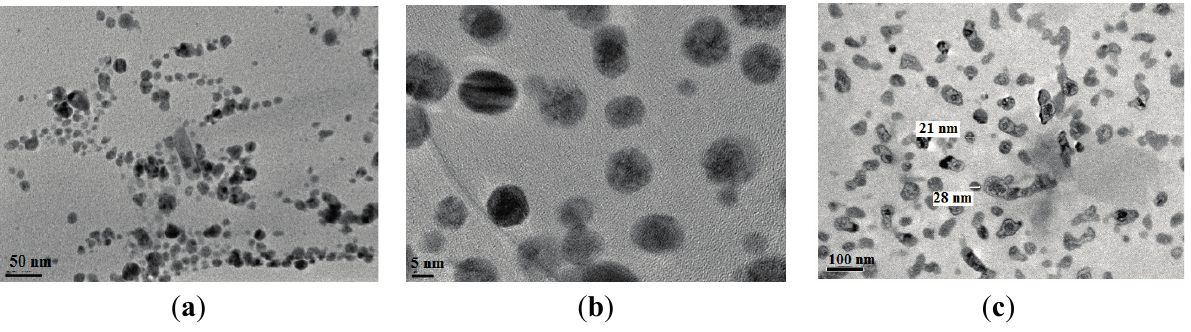
Figure 2. TEM micrographs of ( a ) hydrophilic magnetite coated with PVP; ( b ) hydrophobic magnetite coated with oleic acid and ( c ) AA-Na/magnetite composite.